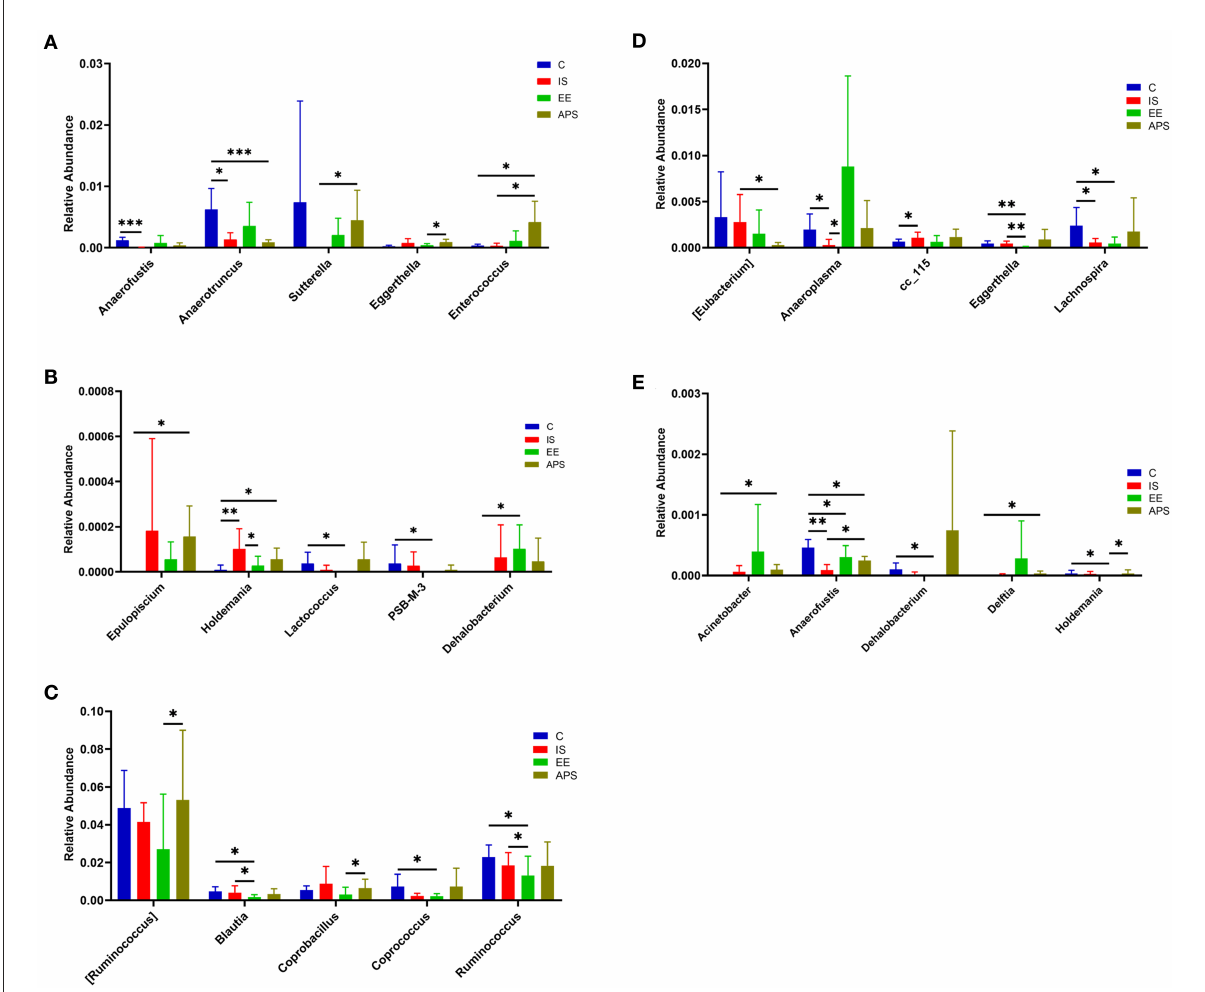
FIGURE3 (A,B) Represent the abundance distribution of the top 10 taxa with the most significant differences between groups at 7 days; (C–E) represent the top 15 taxa with the most significant differences at 14 days Abundance distribution of the taxa (* P < 0.05; ** P < 0.01; *** P < 0.001) ( N =